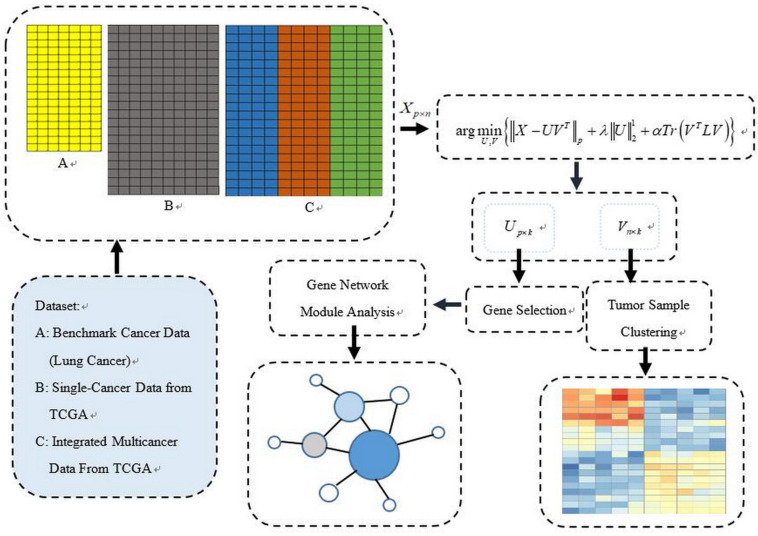
The general schematic framework of the PL21GPCA methodology.